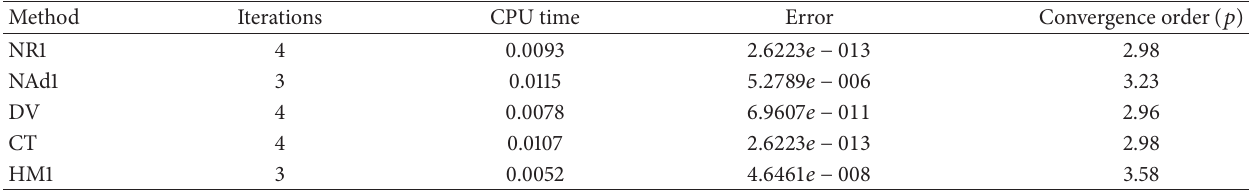
Table 7: Numerical results of Example 5 with initial value 𝑥 0 = (−2,−2,...,−2) 𝑇 .